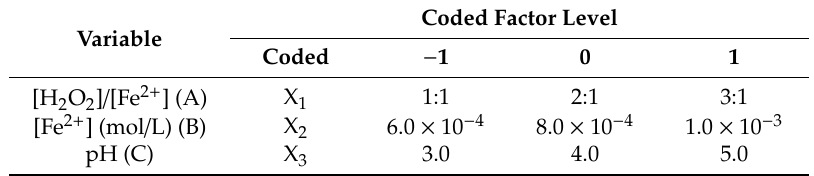
Table 6. Independent variables and levels used in the Box–Behnken design for Fenton